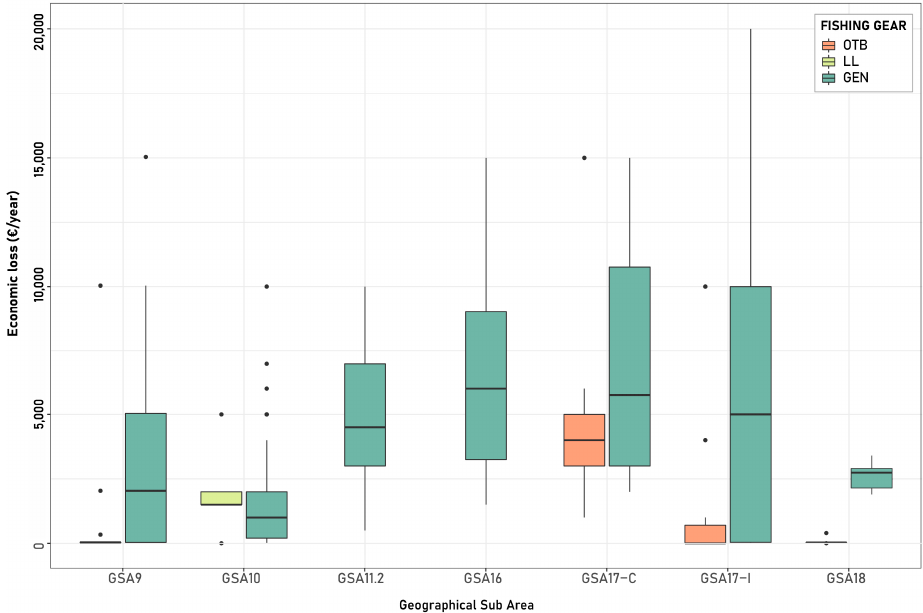
Figure 4. Estimated annual cost of damages caused by dolphins organized by area and type of fish- ing gear (set nets: GEN, bottom trawl: OTB, longlines: